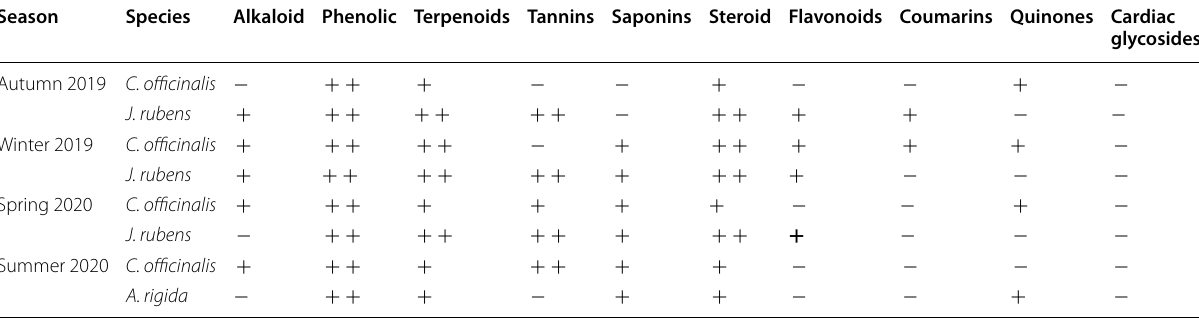
Table 3 Seasonal variation in the phytochemicals content of the methanolic extract of the studied calcareous species ( present, means −